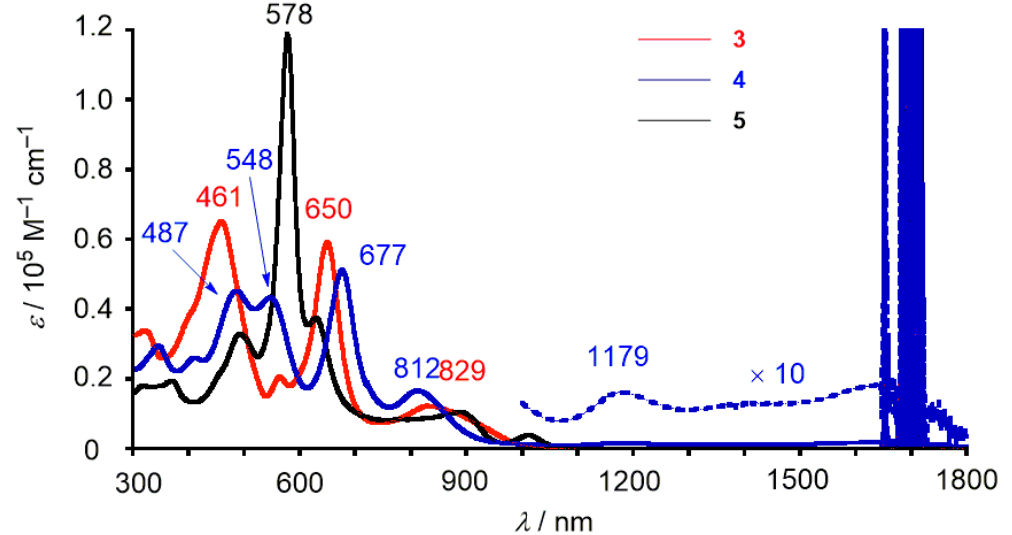
Figure 4. Absorption spectra of 3 (red), 4 (blue) and 5 (black) in CH 2 Cl 2 .